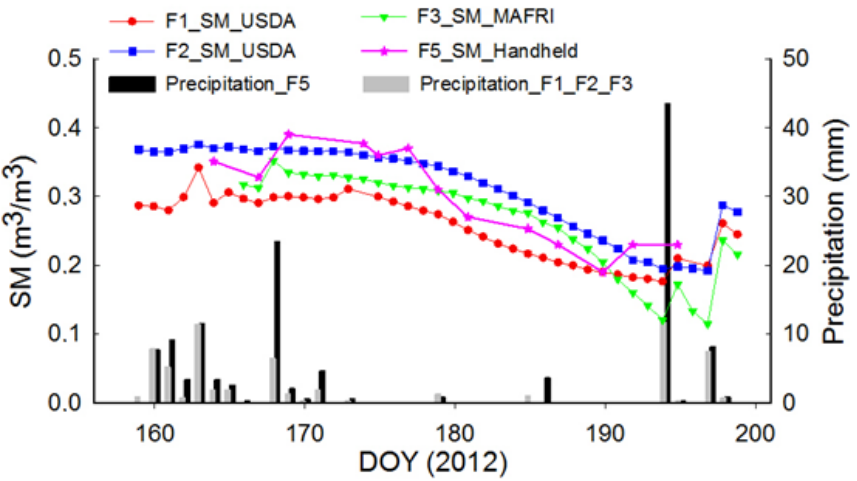
Figure 2. Temporal profile of soil moisture and precipitation over F1, F2, F3, and F5 forest sites. Surface roughness : Soil surface roughness parameters (rms height, correlation length) were measured at two locations over the F1, F2, and F3 sites and at one location over the F5 site in the look directions of RADARSAT-2 and UAVSAR sensors. For each location and each look direction, the measurements result from a 3-m profile obtained by combining three measurements of a 1-m long pin profilometer with a sample resolution of 0.5